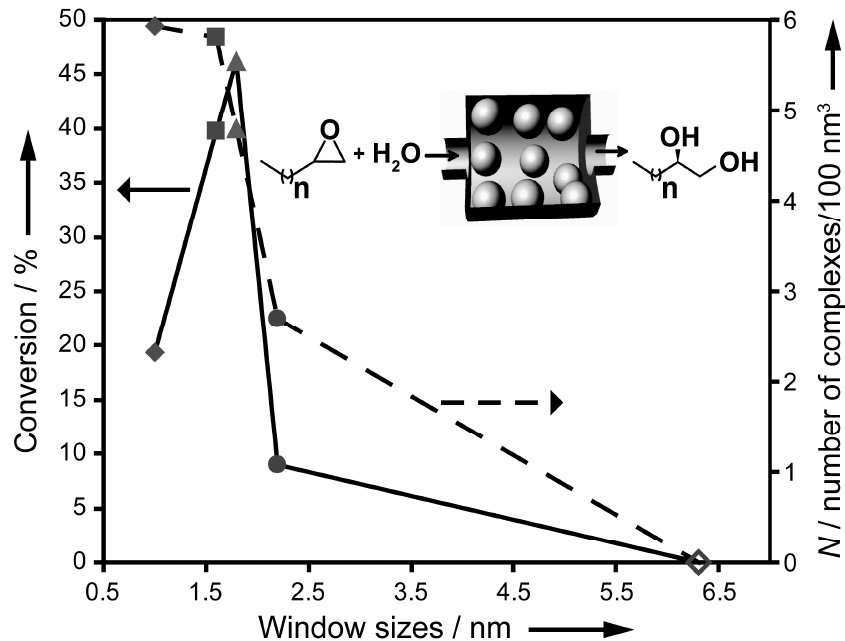
Figure 10. Percent conversion of 1,2-epoxyhexane and N (number of chiral (salen)Co III complexes per 100 nm 3 ) versus window size by catalyst 1 ( ♦ ), 2 ( ■ ), 3 ( ▲ ), 4 ( ● ), or 5 ( ◊ ). Reaction conditions: catalyst loading of 0.015 mol% (percent molar ratio of confined chiral (salen)Co III relative to 1,2-epoxyhexane), 0.75 equiv H 2 O (relative to 1,2-epoxyhexane), room temperature, and reaction time of 48 h. The inserted scheme shows the HKR of terminal epoxides using a confined chiral (salen)Co III (spheres) inside the plugged nanochannel of SBA-15. The maximum theoretical conversion is 50%